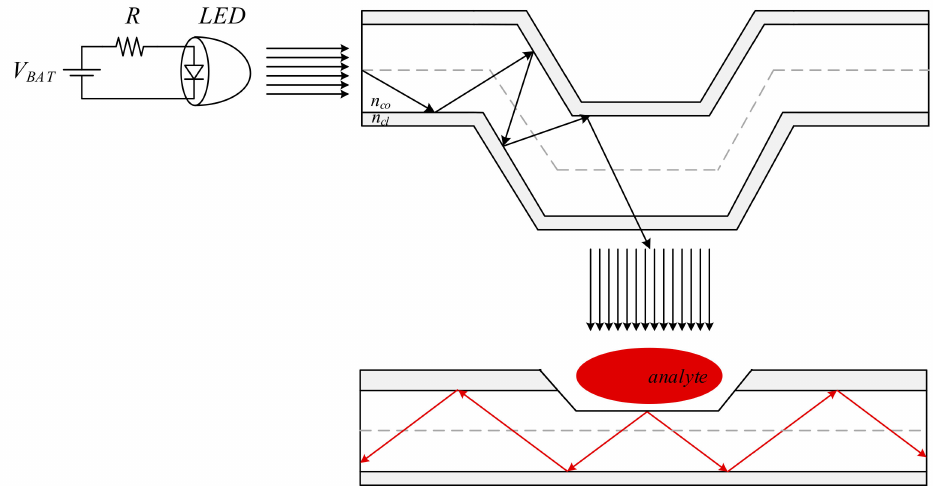
Figure 2. Implementation concept of the extended sensing area intra-oral sensor, consisting of an LED source, a side-emitting fiber, and an end-emitting fiber. Sensing is achieved by having the end-emitting fiber incident illumination applied via a side-emitting fiber, which distributes the incident LED source onto the entire sensing